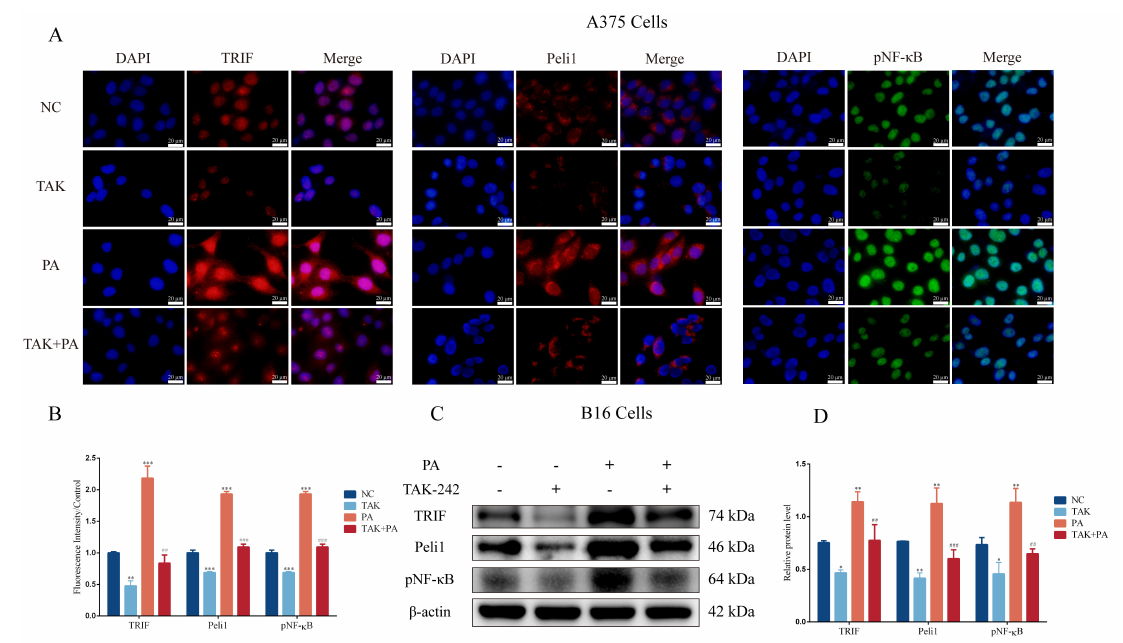
Figure 5. The fluorescence intensity and protein expression of TLR4/TRIF-Peli1-pNF- κ B pathway af- ter TAK-242 treatment. ( A ) The fluorescence intensity of TRIF, Peli1, and pNF- κ B in A375 cells. ( B ) Quantitative analysis of fluorescence intensity. ( C ) The blots of TRIF, Peli1, and pNF- κ B in B16 cells. ( D ) Quantitative analysis of TRIF, Peli1, and pNF- κ B expression in B16 cells. In A375 and B16 cells, treatment with PA or TAK-242 (+) and no treatment with PA or TAK-242 (-). * p < 0.05, ** p < 0.01, or *** p < 0.001 compared with the control group. ## p < 0.01 or ### p < 0.001 compared with the PA group; the significance of the ANOVA.